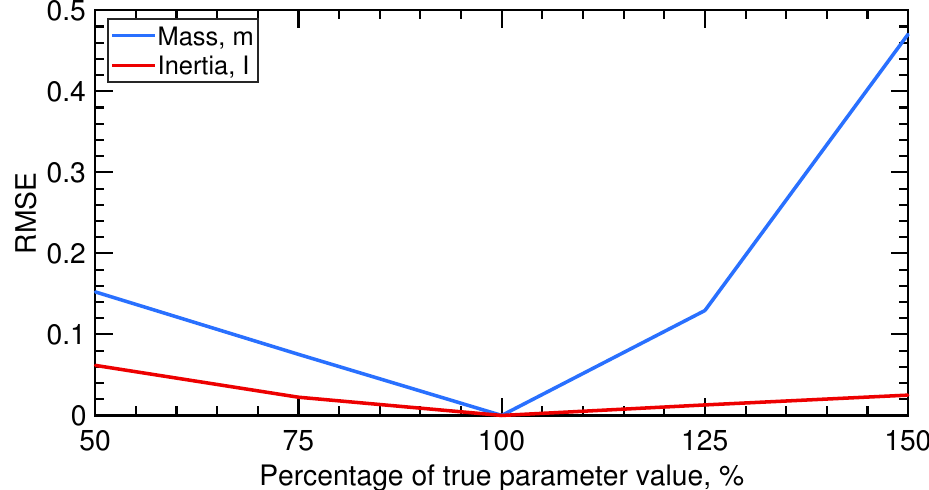
Figure 17. Root mean square error (RMSE) of the vehicle